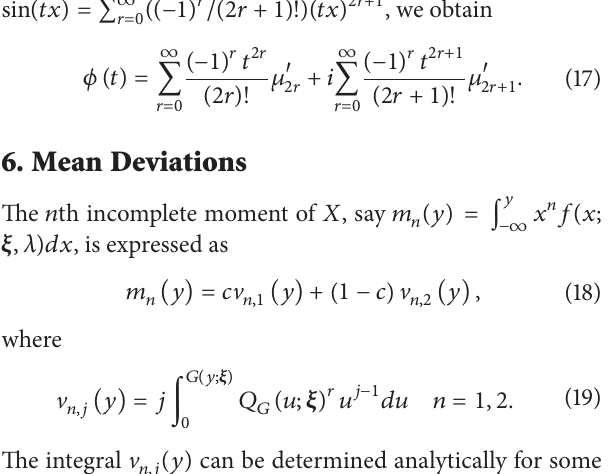
Table 1: Distributions and corresponding